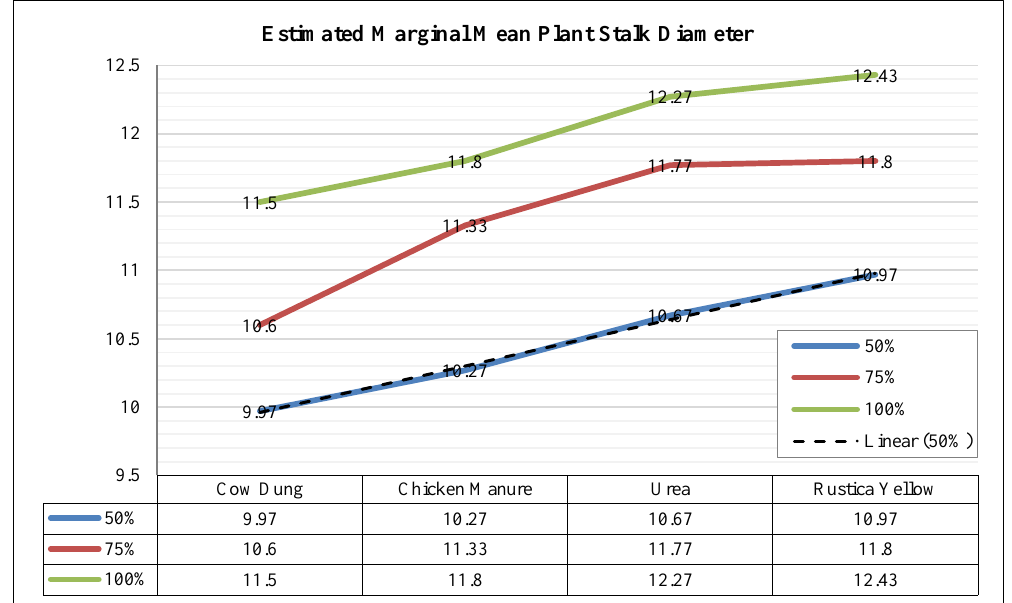
Figure 3. Relationship between Nitrogen Levels and Height of King Grass